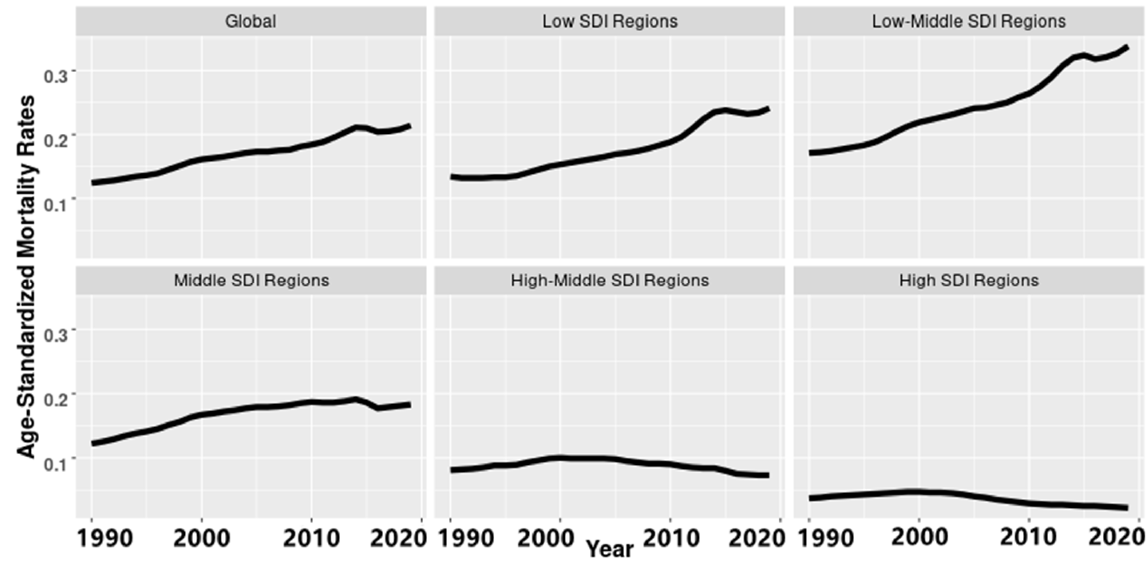
Figure 1. The changes in the age-standardized mortality rate in PM2.5-related neonatal infections according to the global population and various socio-demographic index (SDI) regions from 1990 to